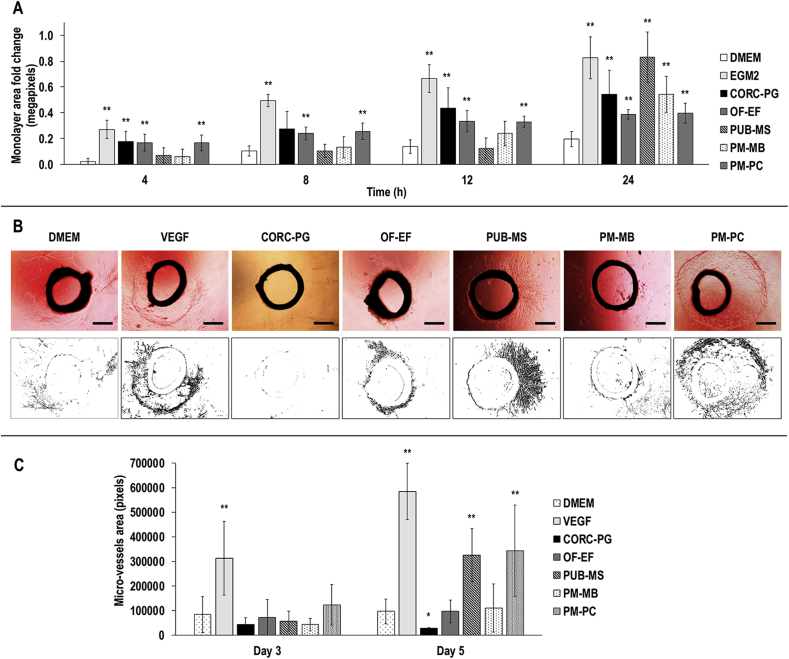
HUVECs scratch assay analysis revealed that after 24 h, all groups demonstrated significantly higher (∗∗) monolayer area fold change (A). Representative images and binary masks of aortic rings at day 5 showed formation of micro-vessels in all conditions except CORC-PG (B). At day 5, the VEGF, PUB-MS, and PM-PC showed the highest (∗∗) and the CORC-PG the lowest (∗) micro-vessels area quantification (C). Scale bars 50 μm. Data are expressed as average ± standard deviation (n = 5 for scratch assay, n = 3 for aortic ring assay). Statistically significant: p<0.05.